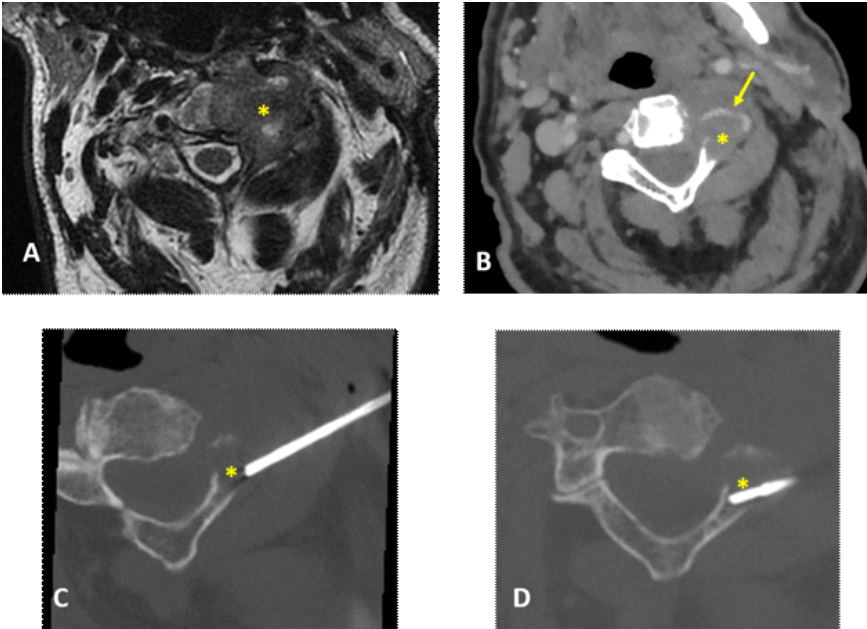
Figure 3. A 79-year-old man: MRI T2w axial ( A ) showed an osteolytic lesion of the axis involving the body and left part of posterior arch (asterisks). Pre-procedural CT scan with intravenous contrast media injection ( B ) was able to define the position of the left vertebral artery (arrow) inside of the target lesion. CT-guided biopsy performed with lateral approach was technically successful with the needle placed within the target lesion ( C , D ), and biopsy specimen was obtained. CT-guided biopsy ( C ) was performed with a posterior approach using a 14G needle (Bonopty). The final histopathological diagnosis on biopsy specimen was multiple myeloma.